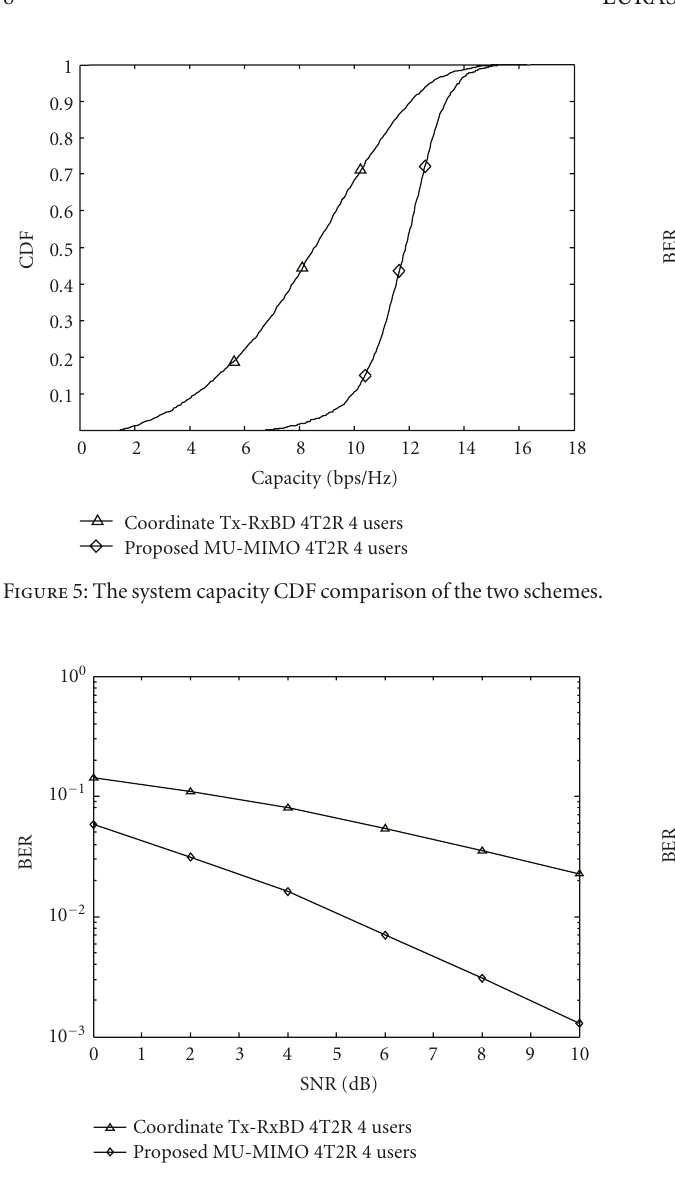
Figure 6: The BER comparison of the two schemes.